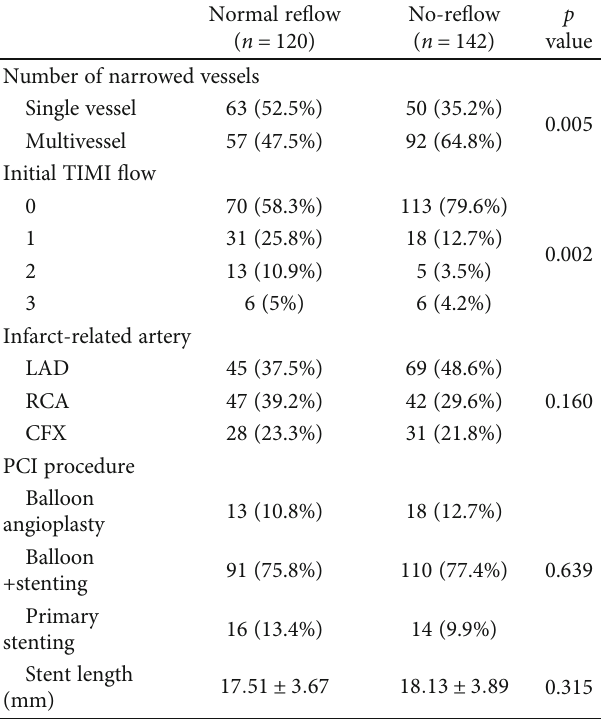
Table 2: Angiographic fi ndings of patients classi fi ed according to no-re fl